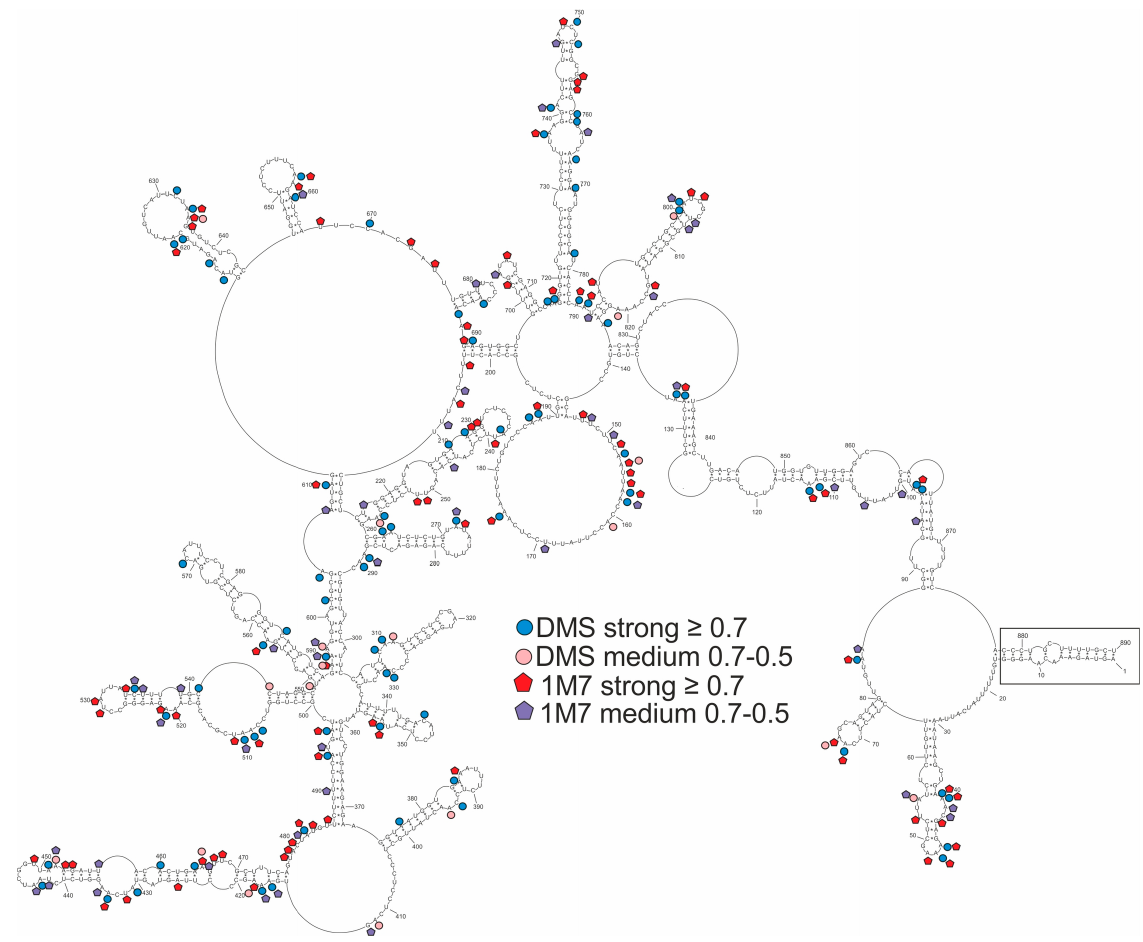
Figure 2. Model of the MFE secondary structure of vRNA8 A/California/04/2009. This global folding model was predicted according to chemical probing with DMS and 1M7 (SHAPE) in cell lysates. Strong ( ≥ 0.7) and medium (0.7–0.5) reactivities are marked on the structure. The panhandle structure between the 3’ end and 5’ end is marked. Due to the limitations of reverse transcription as well as the readout method, there are no data from 1–38 nt, 818–890 nt (1M7); and 1–13 nt, 827–890 nt (DMS).